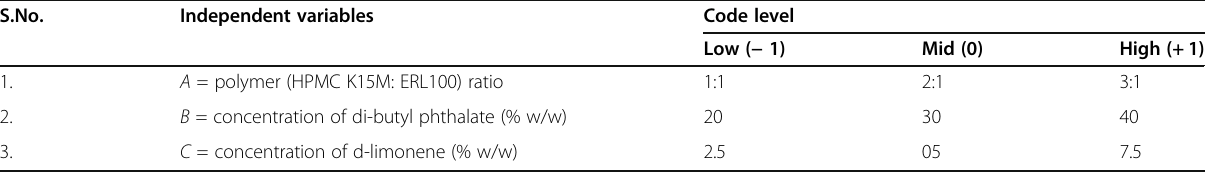
Table 1 Independent variables and levels of experimental design